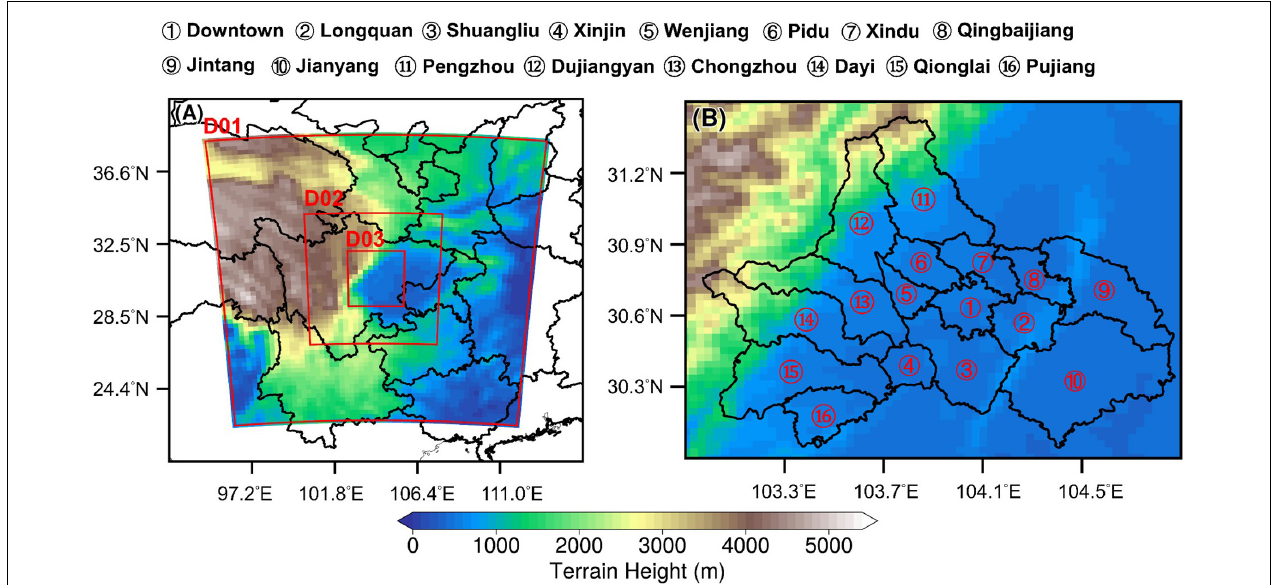
FIGURE 1 | Terrain map of the triple nested model domain (A) and subdistricts in Chengdu (B) .